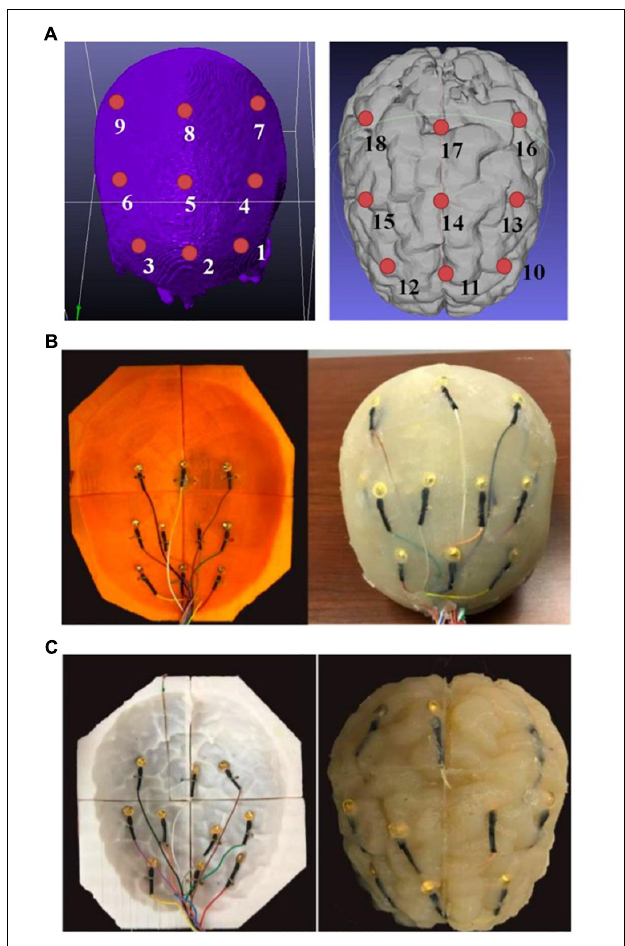
FIGURE 9 | (A) A schematic of the positions of the monitoring electrodes on the skull (left) and gray matter tissue (right) layers; (B) embedding monitoring electrodes at the skull layer, and (C) embedding monitoring electrodes at the gray matter layer of the phantom.